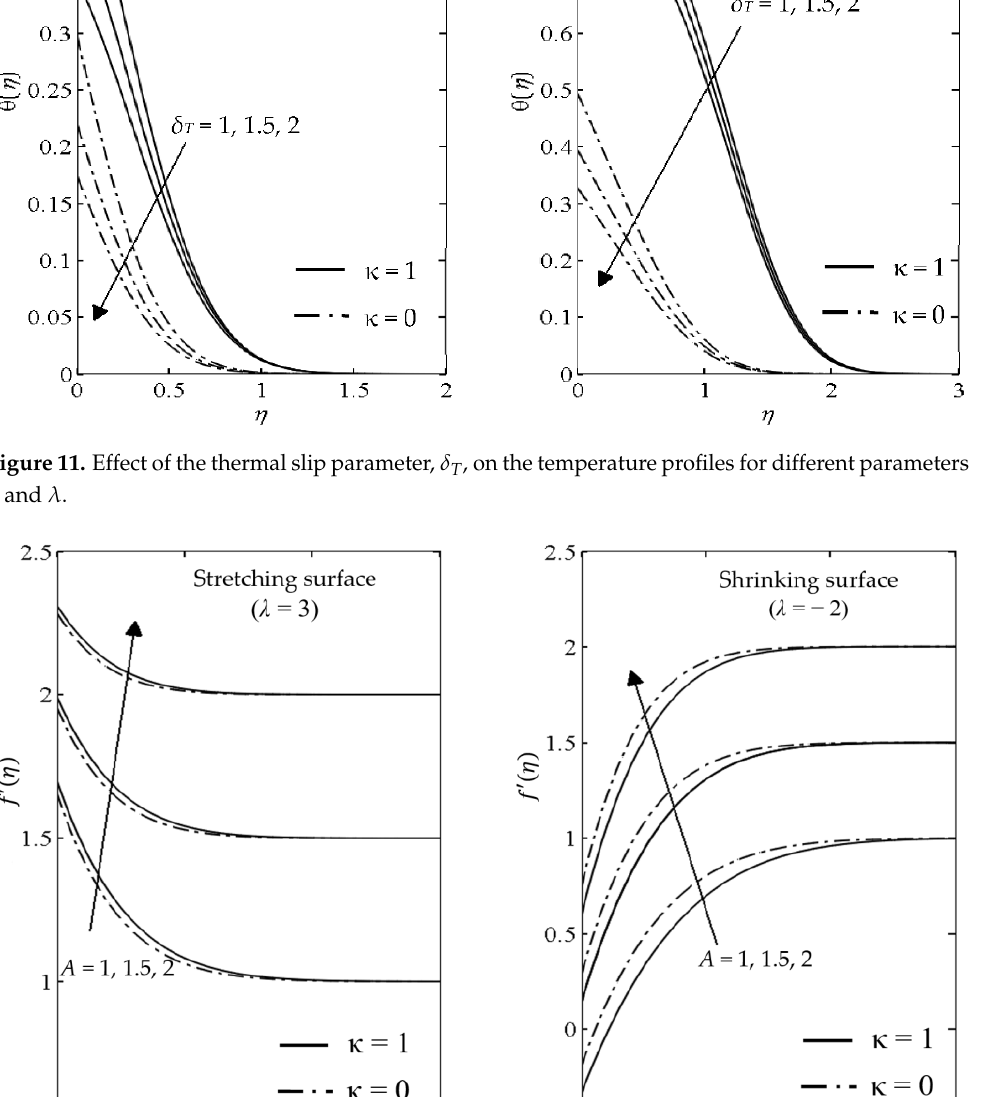
Figure 12. Effect of the velocity ratio parameter, A , on the velocity profiles for different parameters κ and λ .